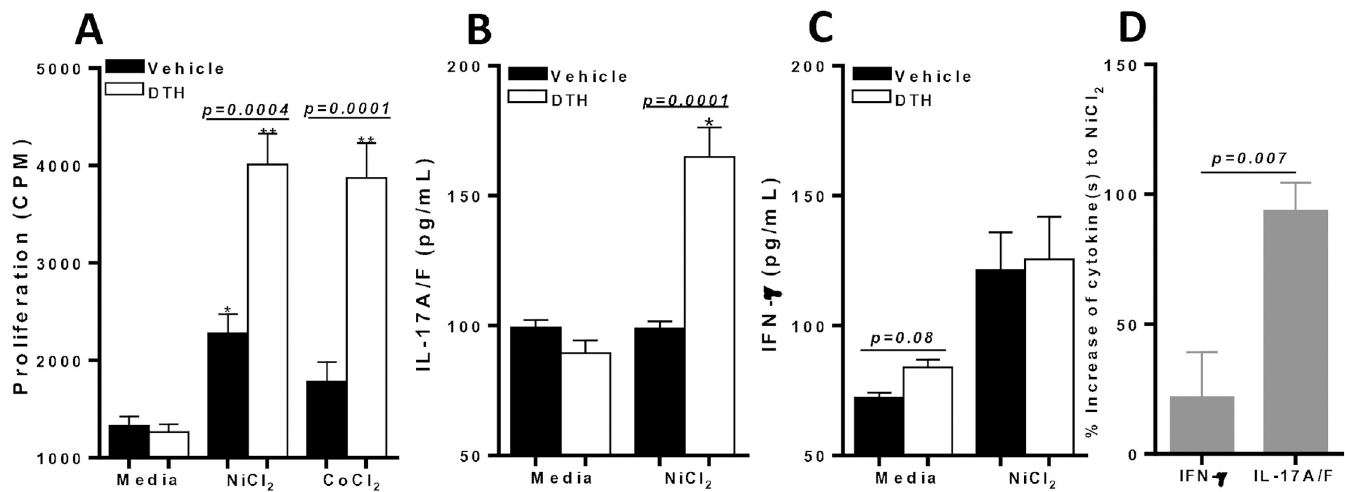
Fig 2. Metal-DTH responses to implant debris in metal-sensitized C57BL/6 mice induces metal-reactive CD4+ T cells. At D 14, spleens were harvested. CD4+ T cells were purified from mouse spleens and co-cultured with mitomycin-C treated na ï ve total spleen cells with or without Ni (0.001mM) or Co (0.001mM) challenge for four days. (A) Proliferation of CD4+ T cells was measured by 3 H-thymidine incorporation. Supernatants were harvested and assayed by ELISA for (B) IL-17A/F and (C) IFN- γ . (D) Percentage increase of produced cytokines in response to Ni challenge, calculated using cytokine production from Fig 1D and 1E from DTH vs. vehicle treated mice. Data represent one of three independent experiments with four mice/group in each experiment. Data are shown as mean ± SEM. Statistical significance was determined by Student’s unpaired two-tailed t-test and asterisk ( � ) denote significant differences P � 0.05.